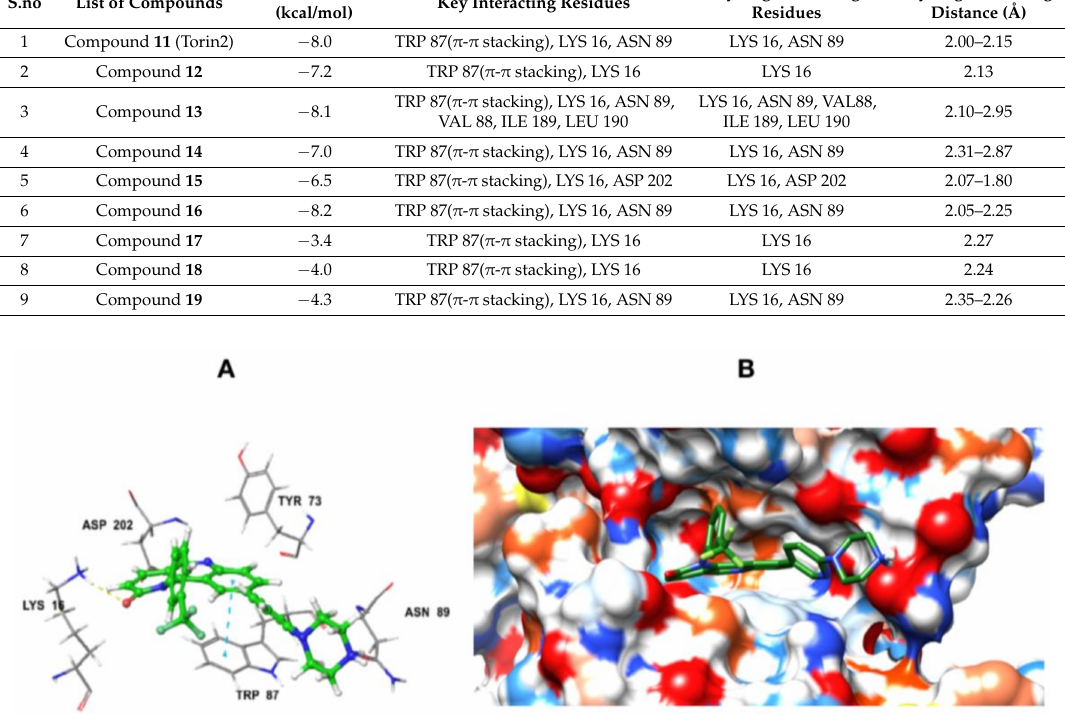
Figure 6. ( A ) Binding pose of compound 14 and its interaction with important residues of ATR kinase. The inhibitor is represented as ball and stick model (green color) and the key residues in the active site are presented as tube model (gray color); ( B ) Electrostatic potential surface representation of ATR kinase binding cavity (blue color: positive potential, red color: negative potential, green color: inhibitor tube